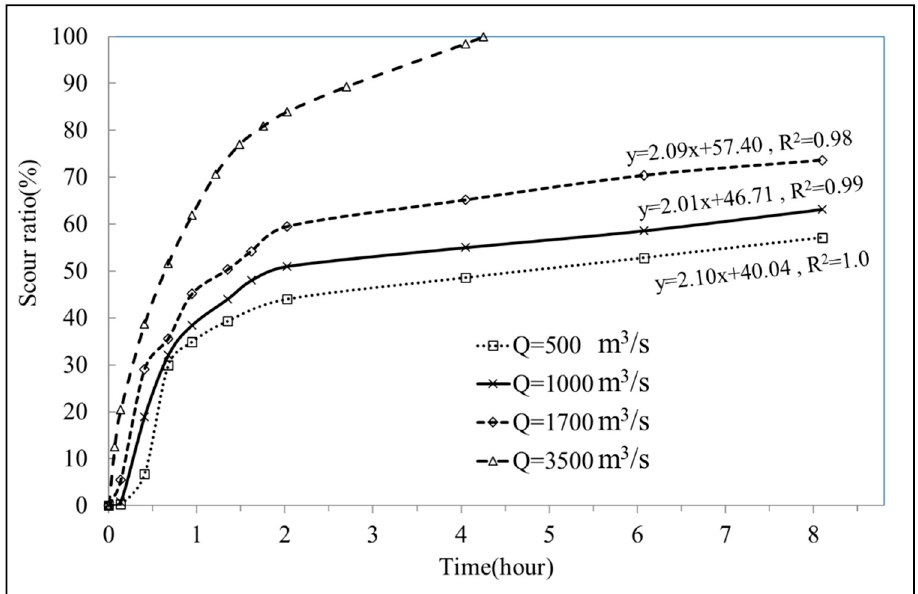
Figure 13. Trends of scour ratio against time for sediment with a water content of 80% at various reservoir flood discharges.